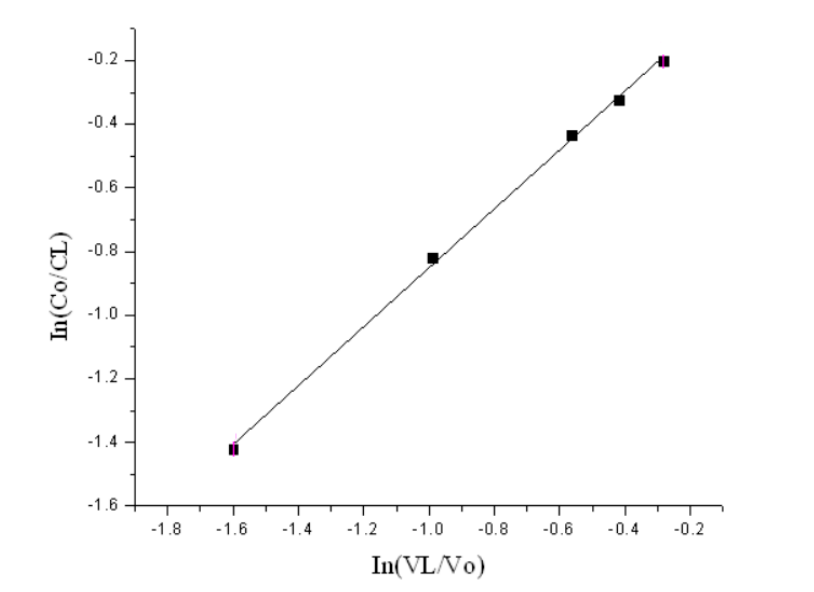
Figure 3. Relationship between Co/C L and V L /Vo when subjecting 5 mg/L Cr(VI) in deionized water to freeze desalination at a temperature of 249.15